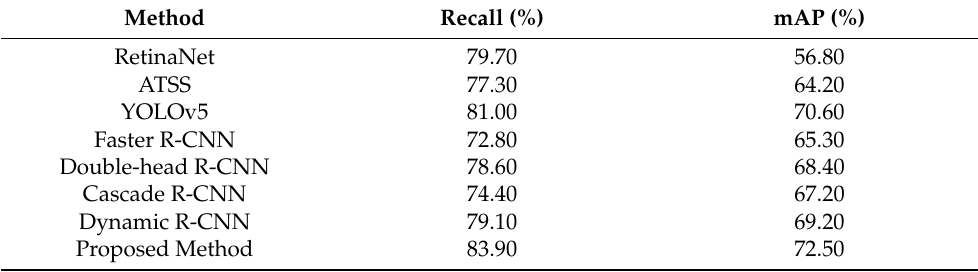
Table 2. Quantitative comparison with different detectors on